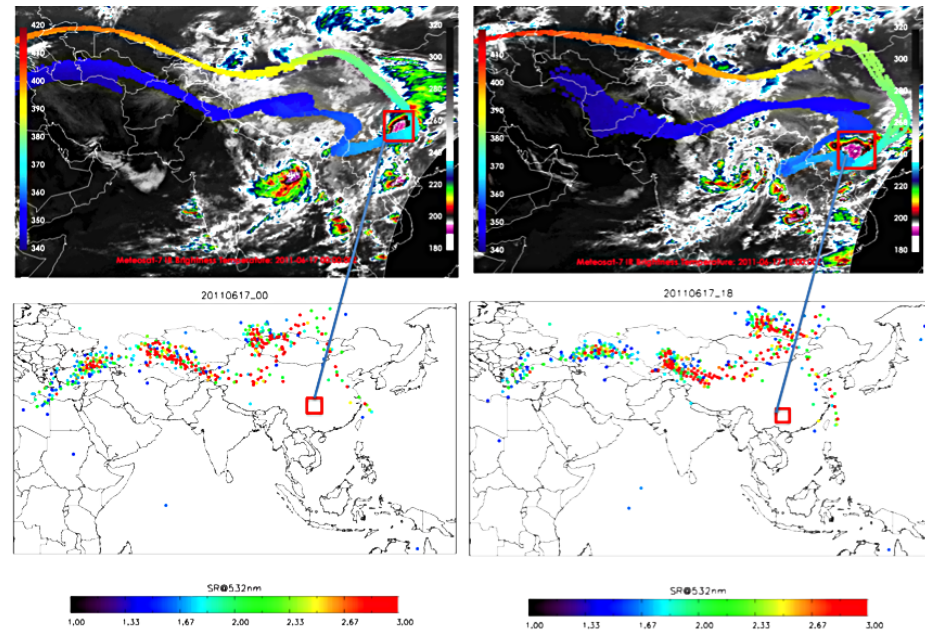
Figure 6. Top panels: 10.8m cloud-top brightness temperatures (BTs) from Meteosat-7 for 17 June 2011 at 00:00 and 18:00Z, with air parcel trajectories, colored by θ , from the source simulation, superimposed. Red squares mark the location of MCSs, with BTs of ∼ 190K. Bottom panels: maps of air parcels observed by CALIOP between 17 and 22 June, with θ >400K, and SR>1.3, which have been trajectory-mapped to coincide with the Meteosat-7 maps (top). Trajectories colored (tagged) by associated